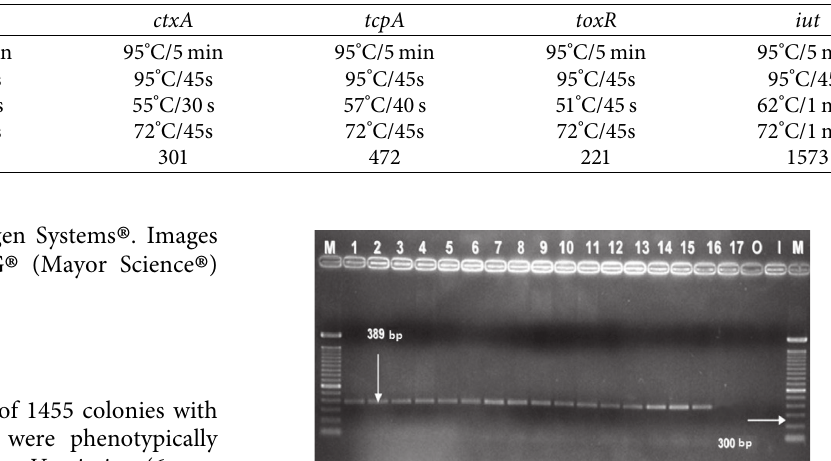
Table 2: Conditions used for the detection of genes.